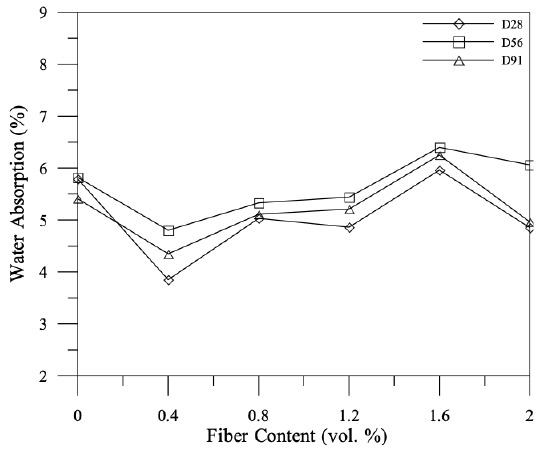
Figure 4. Absorption development curves of poly- olefin fiber concrete with slag.